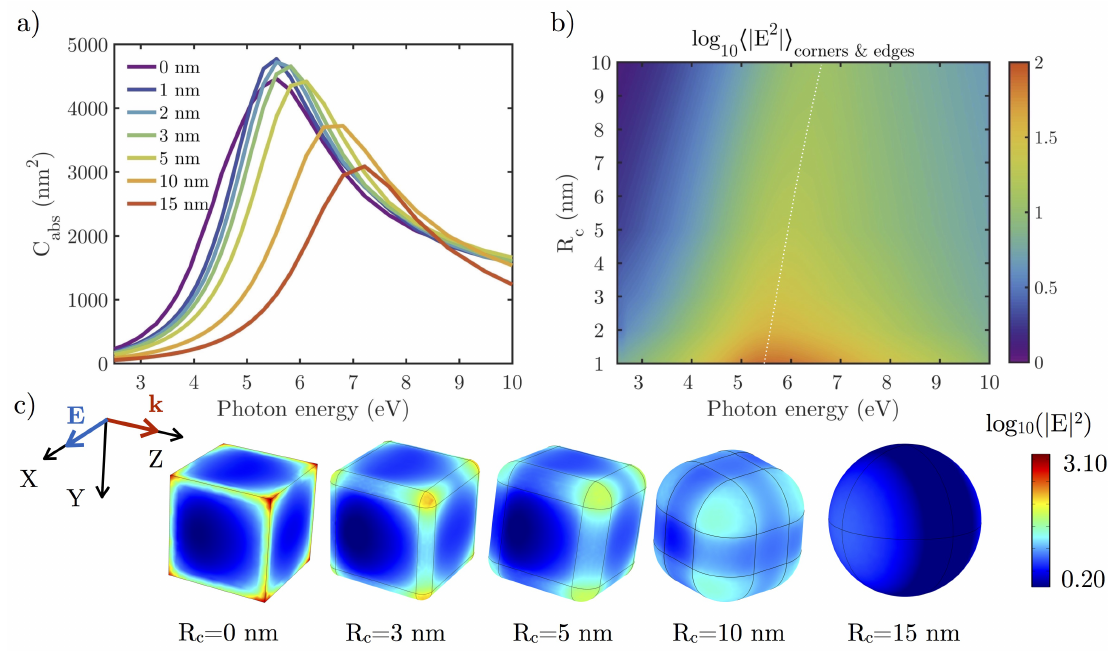
Figure 4. ( a ) absorption cross-sections ( C abs ) of edge length L = 30 nm Rh NCs with rounded edges and corners with a curvature radii R c varying from 0 (perfect cube) to 15 nm (perfect sphere); ( b ) local field enhancement ( | E | 2 ) averaged over the corners and edges (where charge is most concentrated) of the NC with different R c ; ( c ) local field enhancement in logarithmic scale ( | E | 2 ) over the surface of the different NCs when illuminated with the corresponding resonant